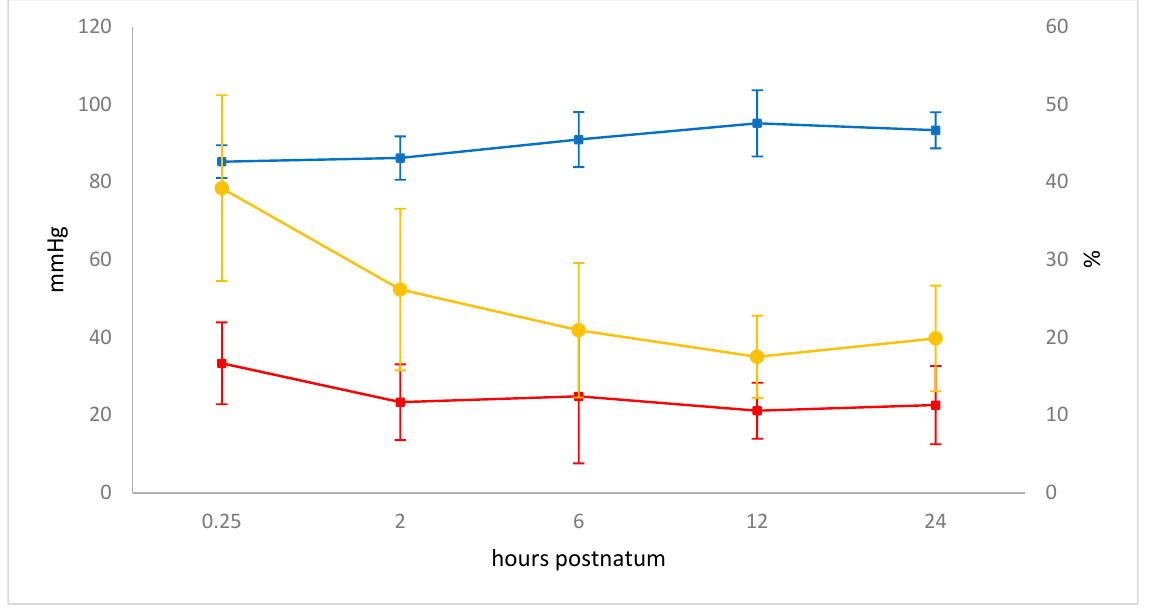
Figure 7. Changes in pAO 2 (blue, p < 0.00001), A–a gradient (red, p < 0.001), and Fshunt (yellow, p < 0.00001) including standard deviations during the study period. The measuring times are graphed equidistantly.